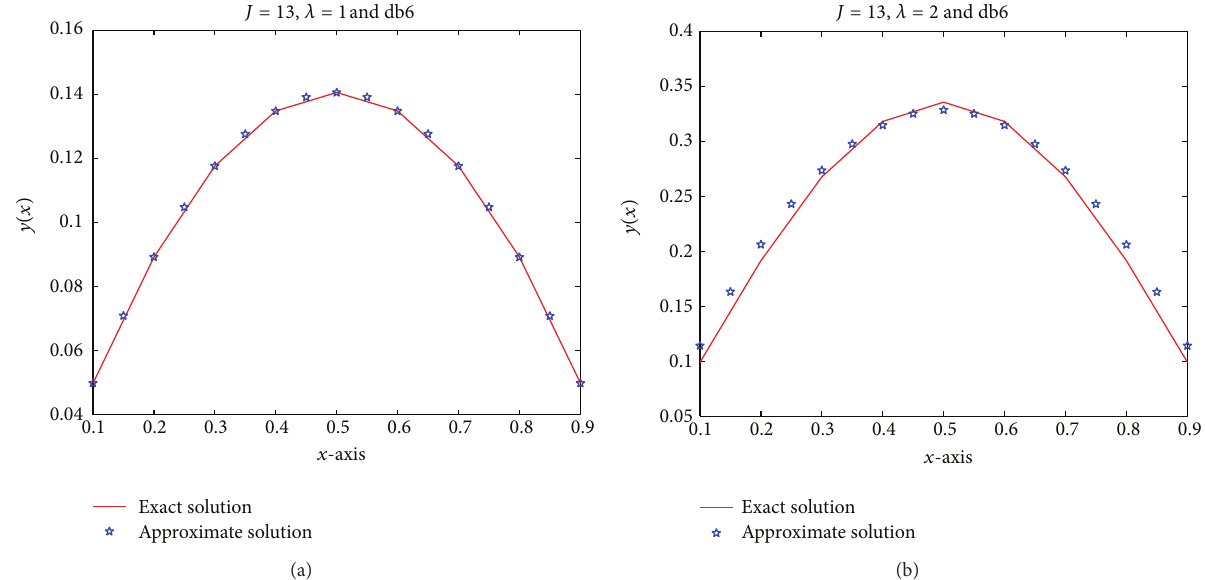
Figure 2: Comparison of exact solution and solution by wavelet-Galerkin method with quasilinearization technique at level of resolution 𝐽 = 13 and we use 𝐷12 as Galerkin bases and at 𝜆 = 1 and 𝜆 = 2 , respectively.